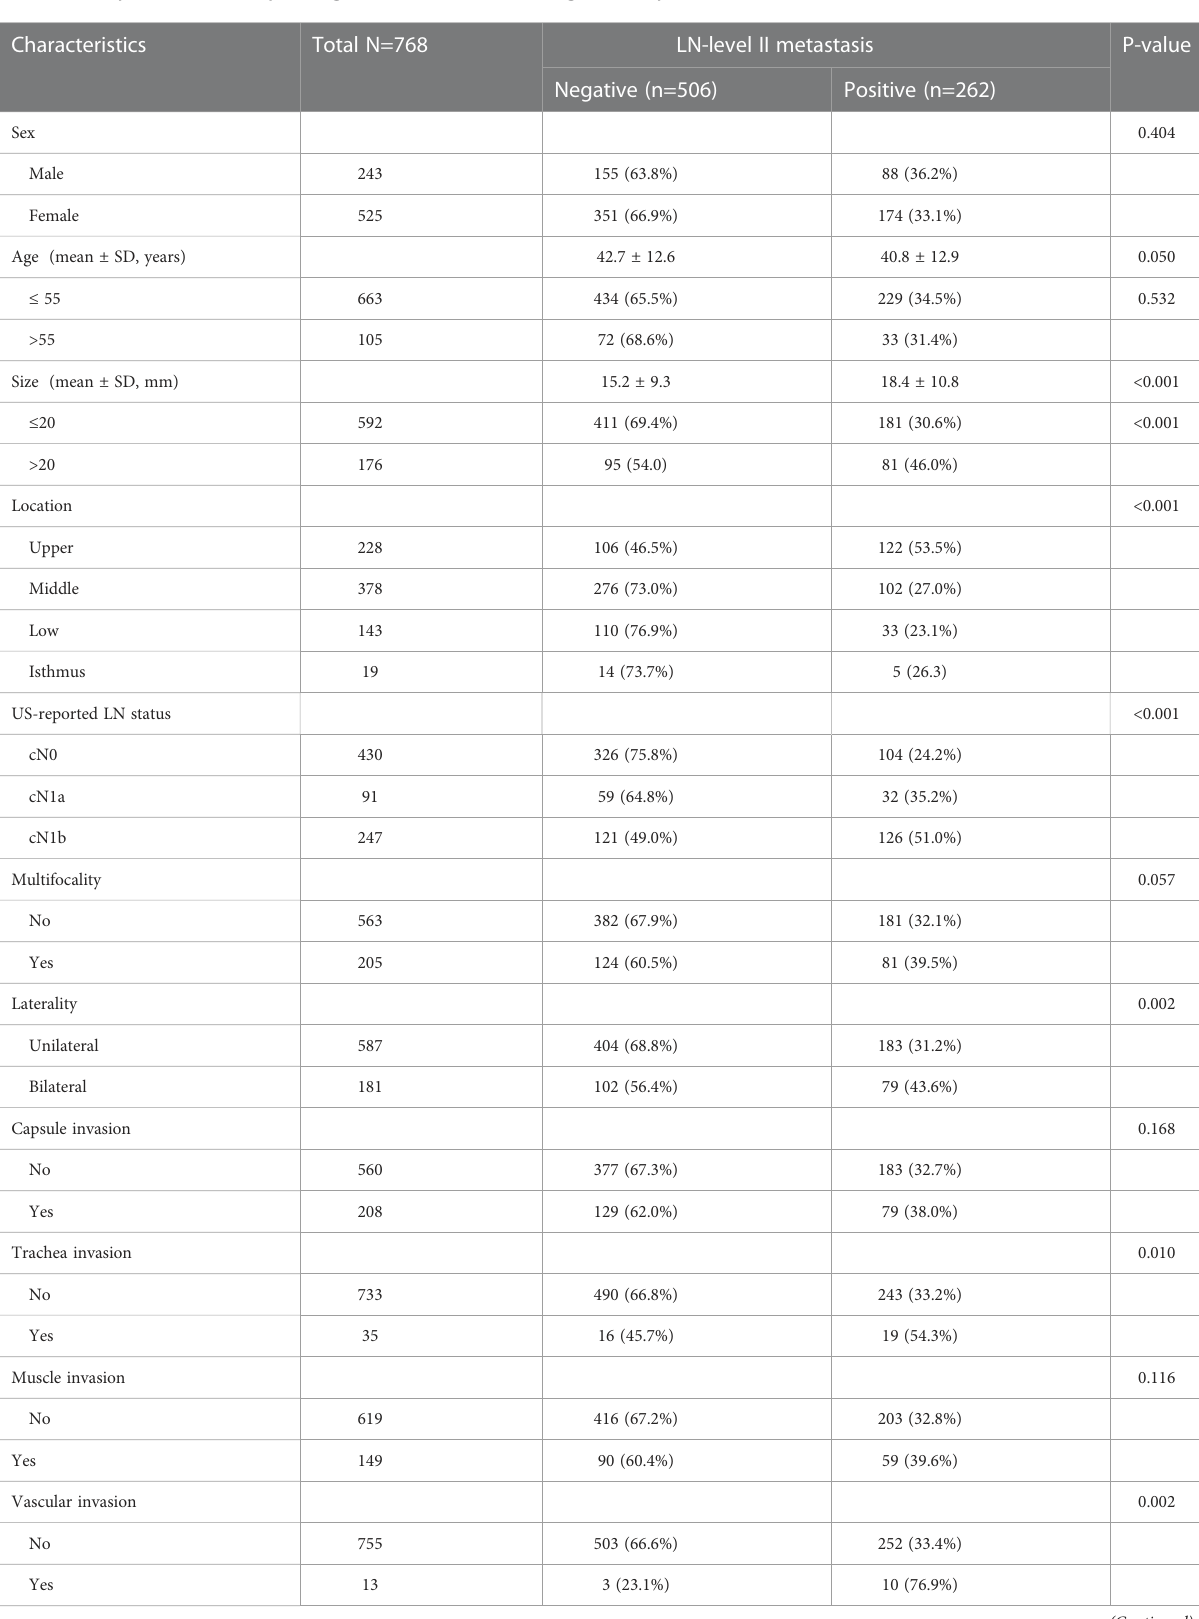
TABLE 1 Comparisons of clinicopathological factors between the negative and positive of LN-level